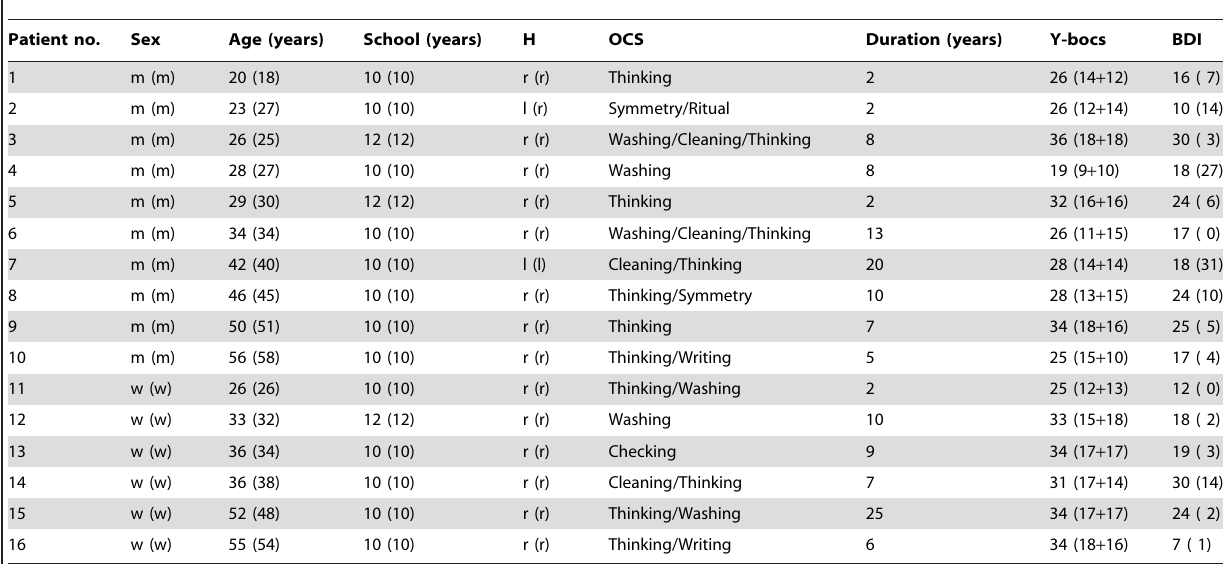
Table 1. Detailed group characteristics of the obsessive-compulsive disorder group and the control group.